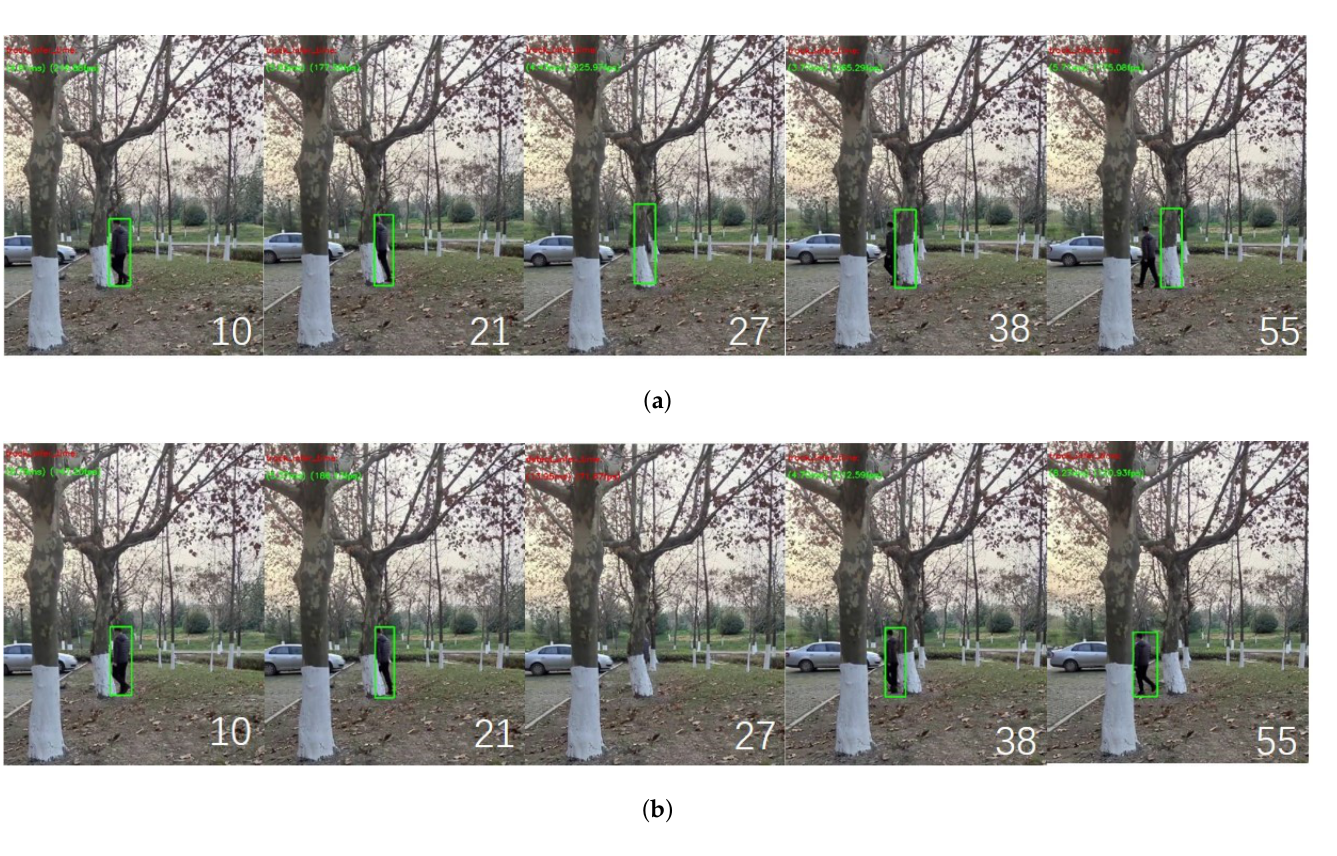
Figure 13. Comparison of SiamRPN and DTE-tracker tracking results. ( a ) The tracking effect of SiamRPN. ( b ) The tracking effect of DTE-tracker.